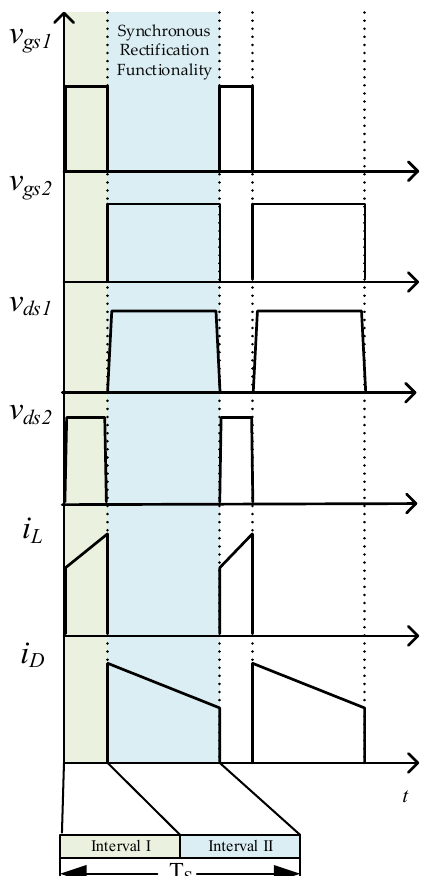
Figure 6. Illustrated main voltage and current waveforms of the bidirectional flyback converter operating in buck mode.